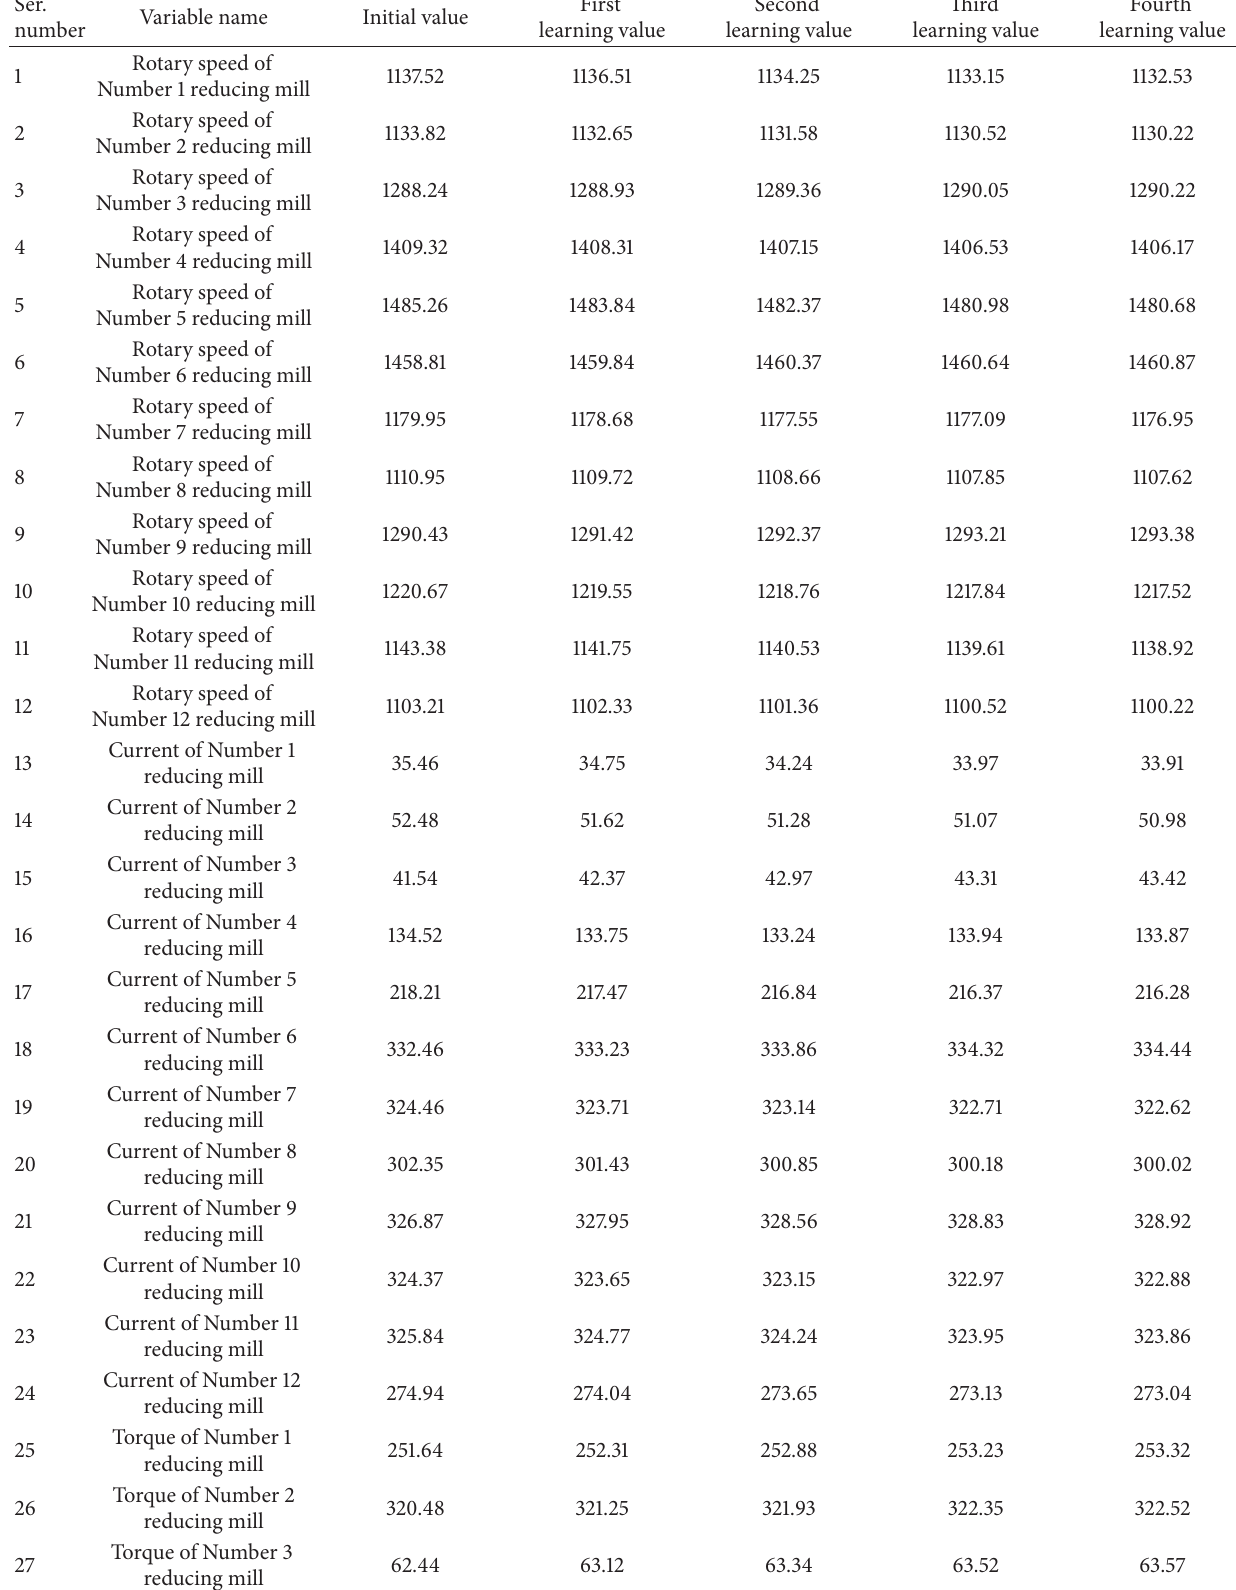
Table 3: Iterative learning calculating result of wall thickness of reducing